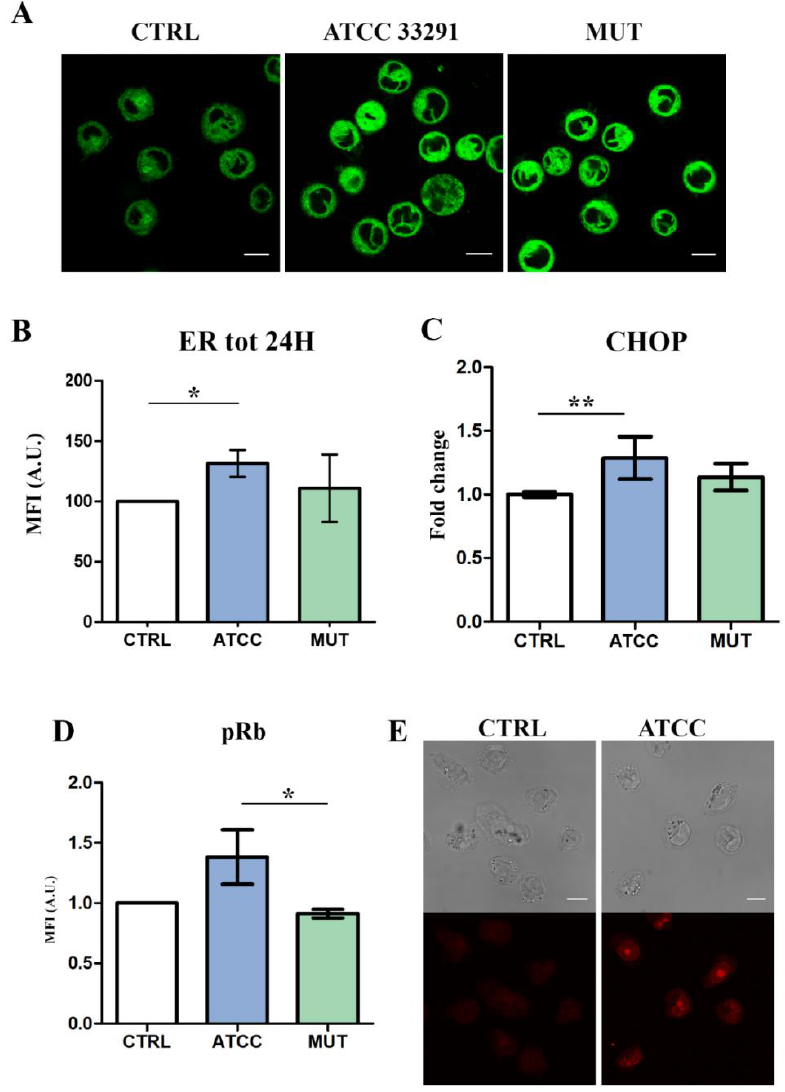
Figure 2. Evaluation of ER involvement by confocal microscopy, flow cytometry, and RT-PCR analyses. ( A ) Single confocal optical sections of ER Tracker MFI of untreated cells and treated U937 at 24 h. Bars: 10 µM. ( B ) Statistical histograms of ER Tracker MFI at 24 h, quantitated by flow cytometry. Each value was converted to arbitrary units (A.U.), setting the control as 100. Each value is expressed as a mean ± SD (results from n ≥ 3 independent experiments). ( C ) Evaluation of C/EBP-homologous protein (CHOP) expression in U937 cells after 24 h from lysate administration. Welch’s unpaired t test revealed: ** p = 0.009 for CTRL vs. ATCC 33291. Evidence of pRb modulation by flow cytometry and confocal microscopy. ( D ) Statistical histograms of pRb intracellular content in U937 cells at 72 h. Each value was converted to arbitrary units (A.U.), setting the control as 1. Each value was expressed as a mean ± SD (results from n ≥ 3 independent experiments). The asterisk denotes a statistically significant difference (* = p < 0.05) between strains. ( E ) Single confocal optical sections of pRb MFI of untreated cells and U937 cells preincubated with the C. jejuni ATCC 33291 lysate for 72 h. Bars: 10 µM.